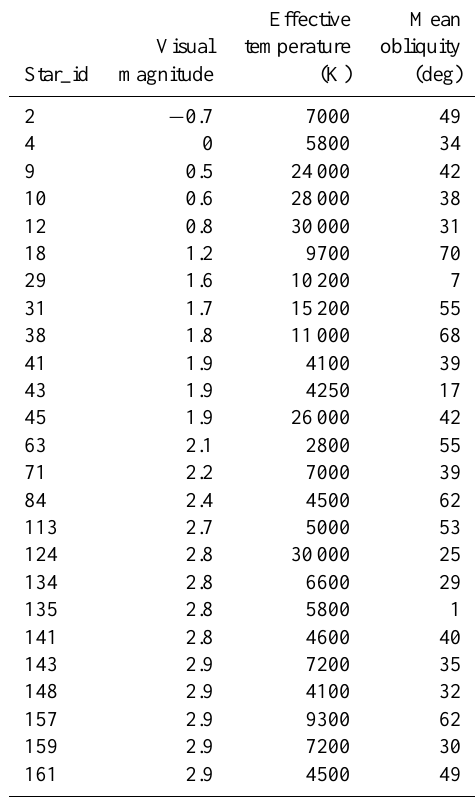
Table 1. Information about the GOMOS occultations used for the analyses (years 2003, 2007, 2008). The obliquity angles are practi- cally the same for different years. The occultations with large obliq- uity angles (>60 ◦ ) were performed in